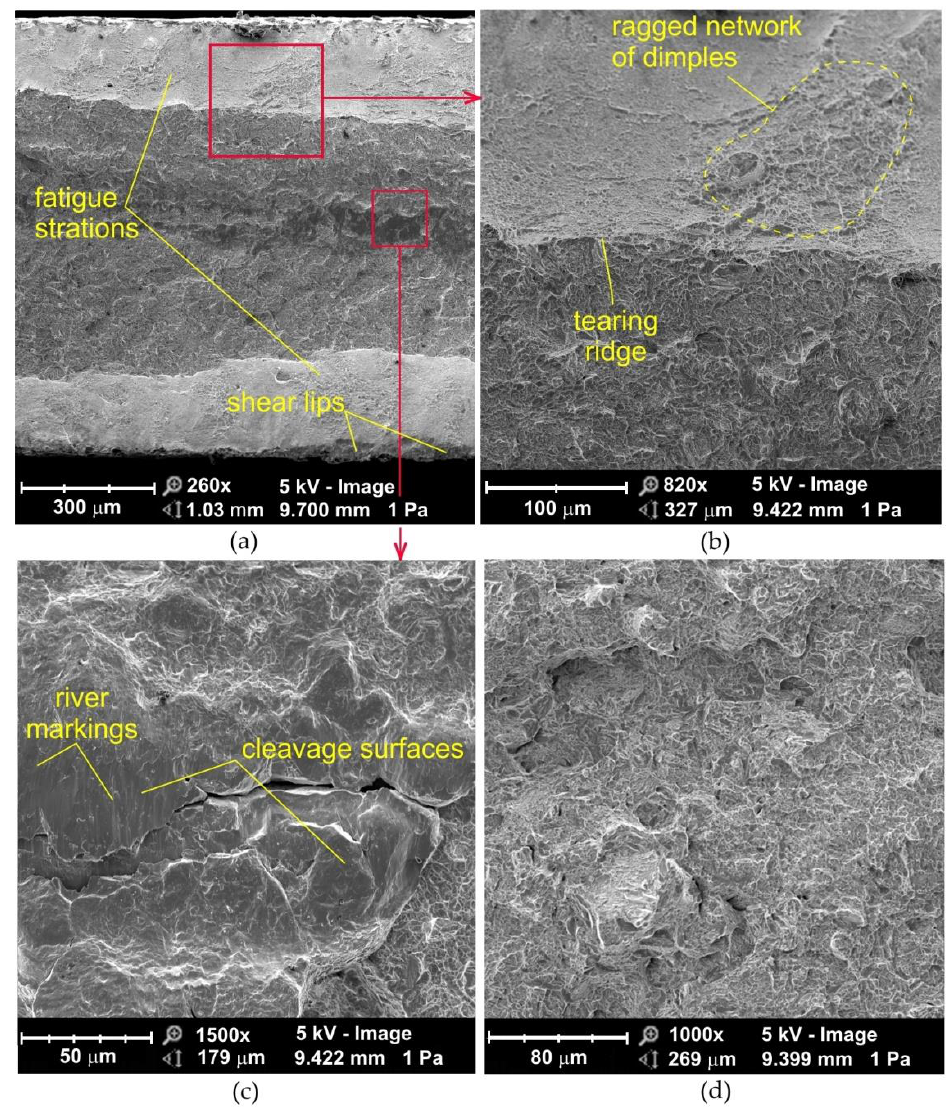
Figure 10. SEM micrographs of the fatigue fracture of non-sandblasted flash butt welded joints tested at a stress amplitude of 460 MPa: ( a ) cross-section of the fatigue fracture, ( b ) magnification of the subsurface area, ( c , d ) magnification of the middle area of the weld.